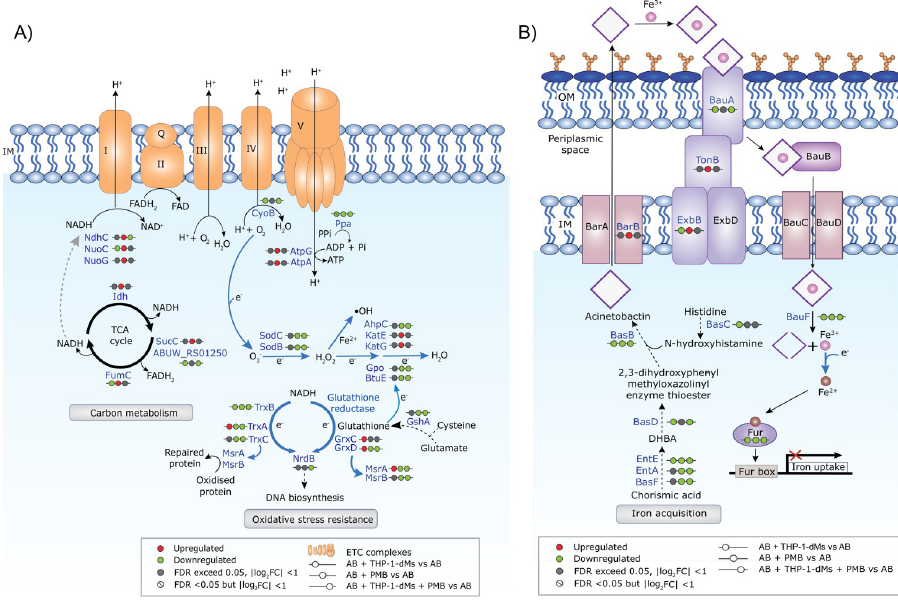
Fig 2. A . baumannii differentially remodels oxidative stress resistance and iron homeostasis following different treatments. Schematic diagram illustrating protein networks in AB5075 associated with A ) carbon metabolism and oxidative stress resistance, and B ) acinetobactin biosynthesis and iron acquisition. Red and green indicate upregulated and downregulated differentially expressed proteins, respectively. Data are presented as mean of three biological replicates per experimental group. IM, inner membrane; OM, outer membrane; ETC, electron transport chain; Gpo, glutathione peroxidase (ABUW_RS11455); GshA, glutamate—cysteine ligase (ABUW_RS00565); NrdB, ribonucleotide-diphosphate reductase subunit beta (ABUW_RS15470); DHBA, 2,3-dihydroxybenzoic acid; EntA, SDR family oxidoreductase (ABUW_RS10080).